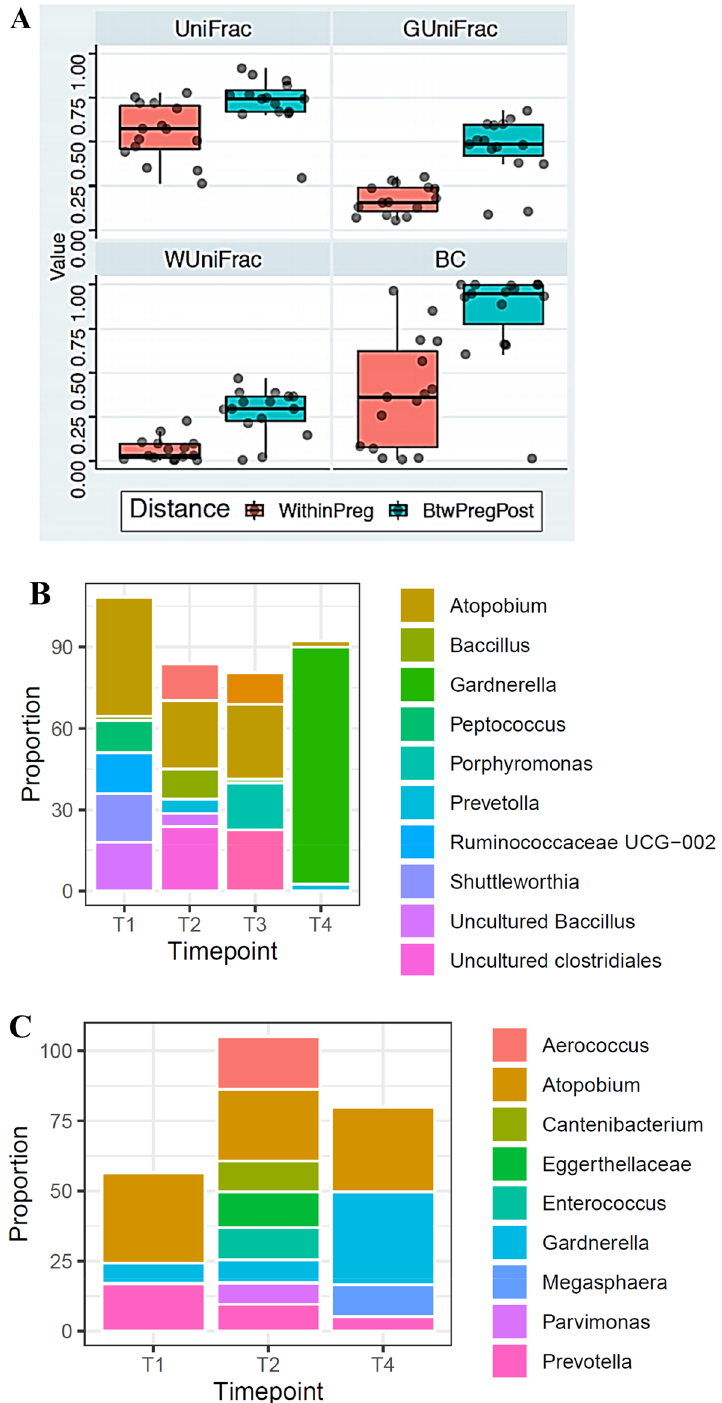
Figure 6. Shift in vaginal microbiome within pregnancy and between pregnancy (term and preterm birth) and postpartum vaginal samples. (A) A compositional dramatic shift in the postpartum vaginal microbiomes was observed such that the distance between samples during pregnancy is much smaller than the distance between pregnancy and postpartum. Wilcox paired test p = 0.008, 0.0002, 6e−5, 0.003 for UniFrac, GUniFrac, WUniFrac and BC distance, respectively. (B) Atopobium vaginae persistent in participant with late preterm birth throughout gestation but changed during the postpartum to become dominated by Gardneralla vaginalis . (C) Atopobium vaginae persistent in participant with early preterm birth throughout gestation but switched at postpartum to become dominated by Gardneralla vaginalis